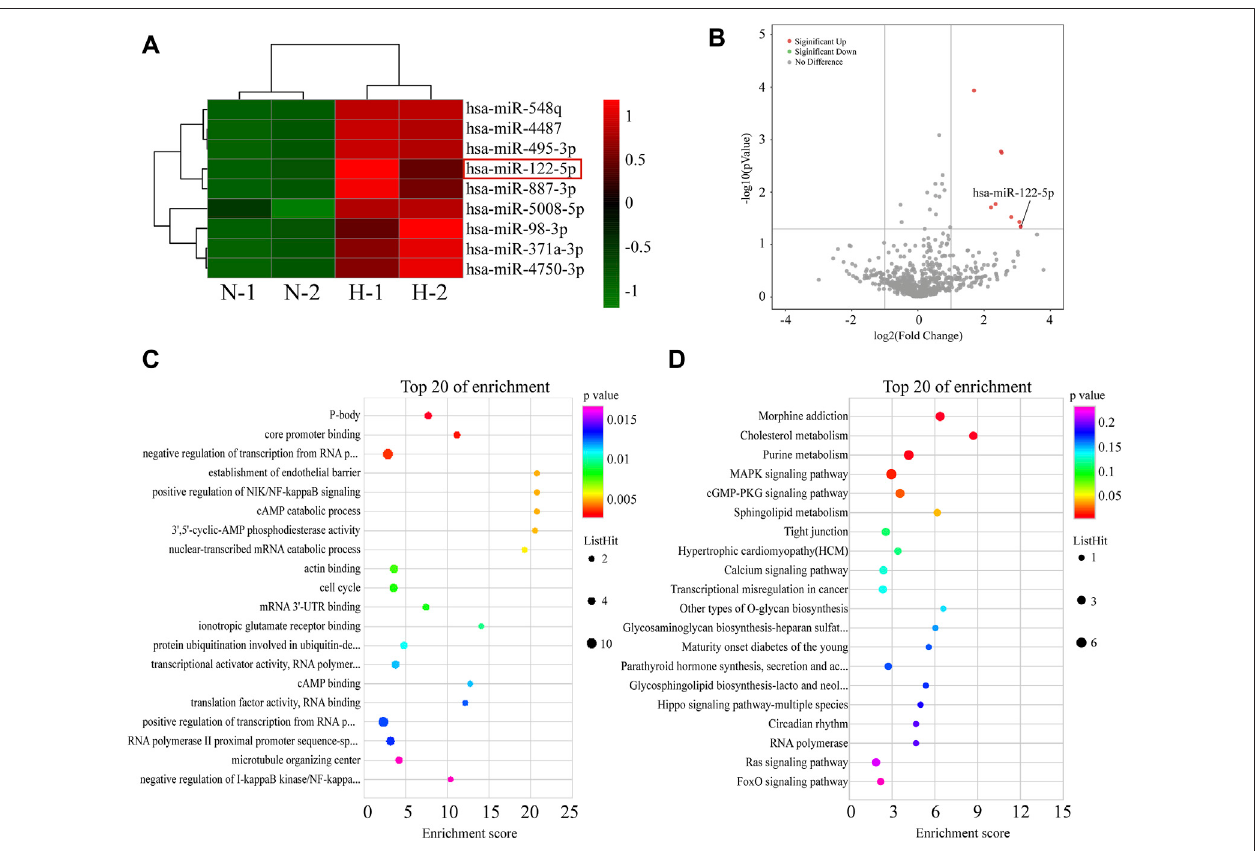
FIGURE 4 | Screening of differentially expressed miRNAs between EVs from normoxic or hypoxic HIEC cells. (A) The differential miRNA clustering showed in heat map and (B) volcano plot. The top 20 terms in (C,D) GO and KEGG analysis of targeted genes of differential miRNAs. N, normoxic EV-derived miRNAs; H, hypoxic EV- derived miRNAs.